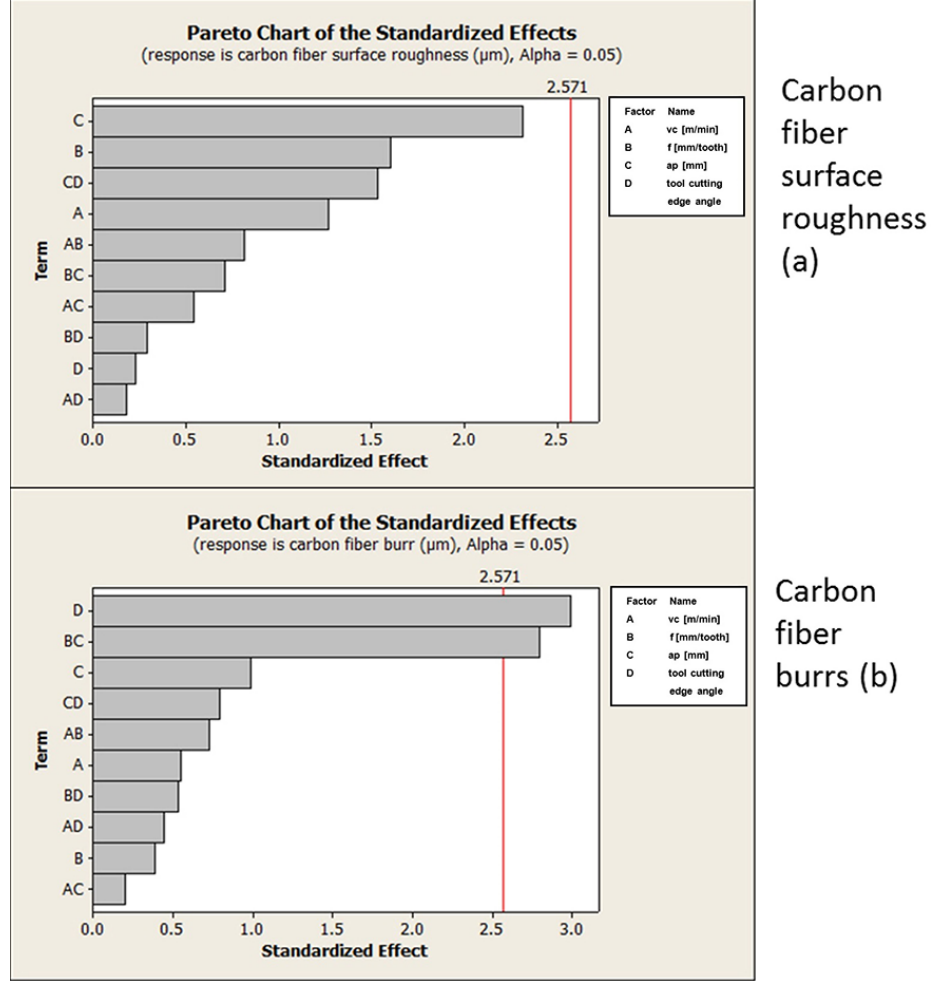
Figure 4. Pareto charts for carbon